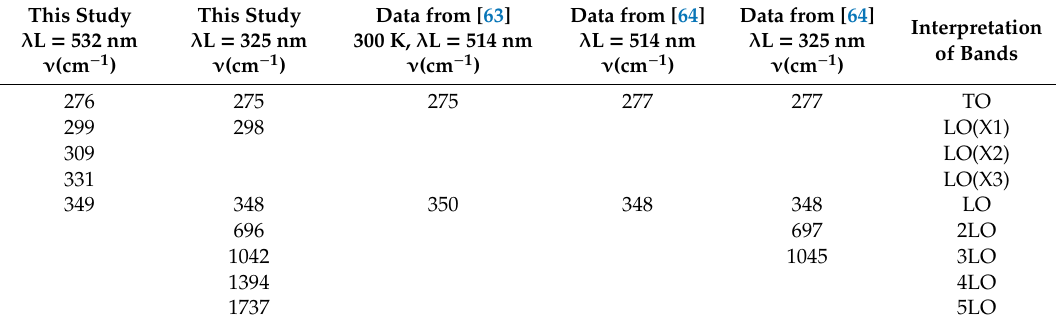
Figure 12. Raman spectra of the Tulul Al Hammam CM sphalerite at 532 ( A ) and 325 nm ( B ) excitation. See resonant light scattering in the UV excitation pattern, with several overtones (Table 13) of the main tone (LO mode 348 cm − 1 ). The spectras of record a calcite microinclusion (band 1086 cm − 1 ) in panels ( A ) and air N2 (sharp band at 2331 cm − 1 ) in ( B ). Table 13. Features of first-order Raman spectra of natural CM sphalerite and their interpretation.